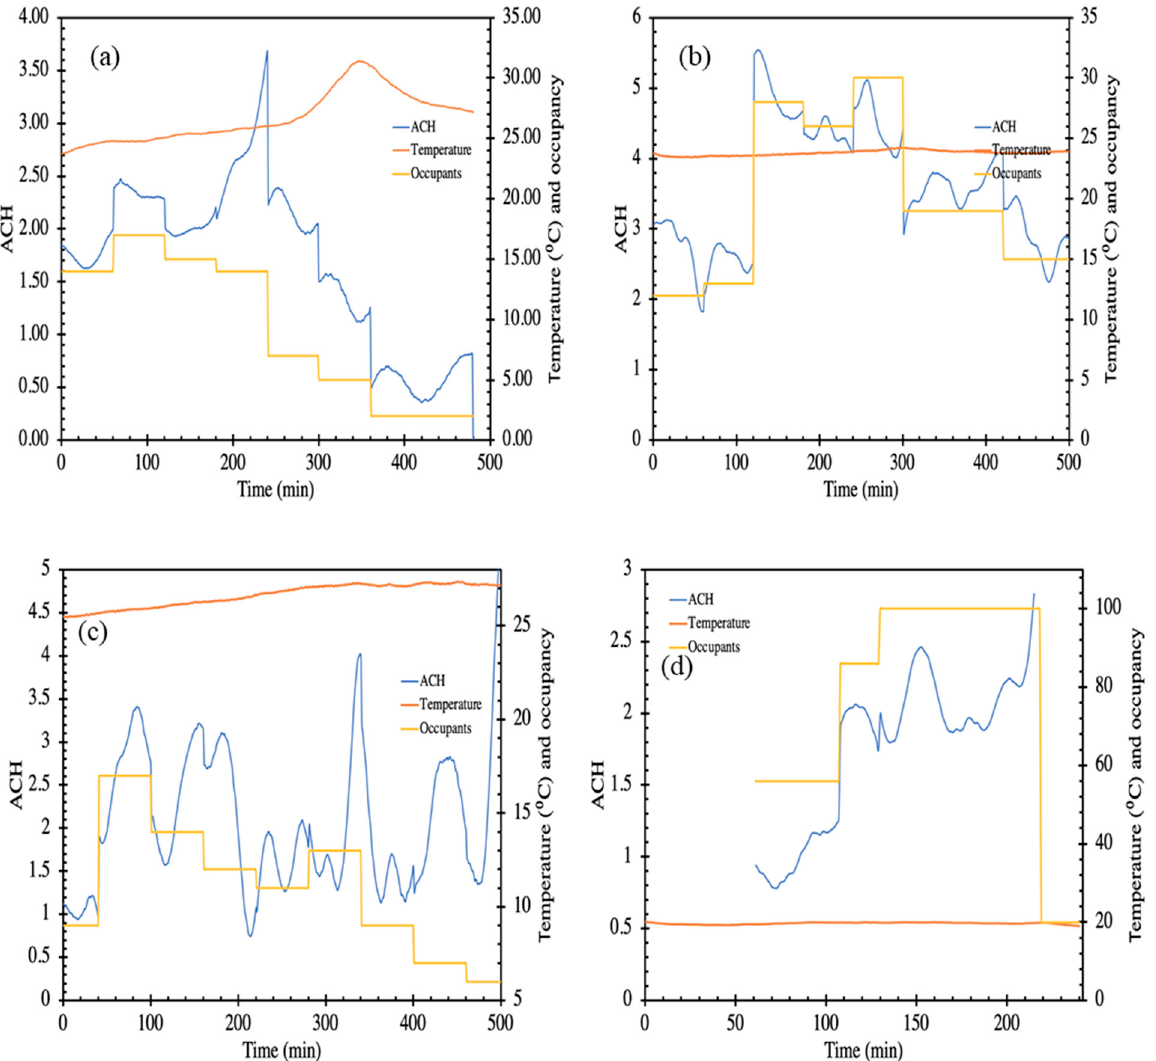
Figure 5. Schematic representation of air changes per hour (ACH), temperature and number of occupants in ( a ) HS3-MDU; ( b ) HS4-EOM; ( c ) HS5-OPR; ( d ) PR. where the primary axes depicting calculated air change per hour (ACH) plotted against time during the occupancy period. The secondary axis shows the temperature and occupancy.